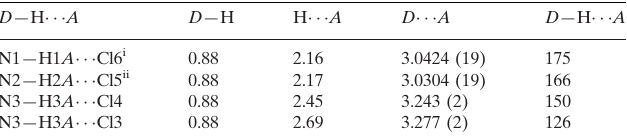
Hydrogen-bond geometry (A˚ , (cid:5)